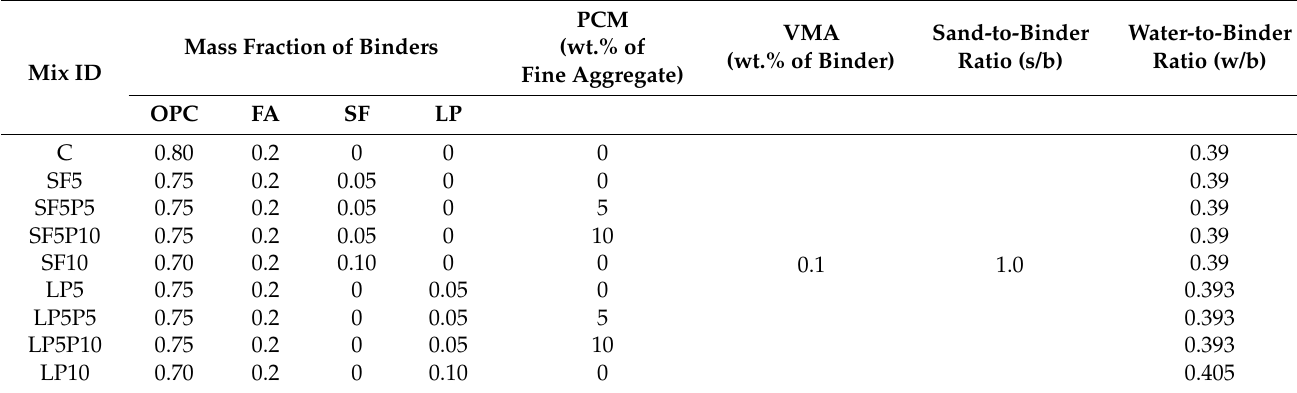
Table 2. Details of the mixture proportion.